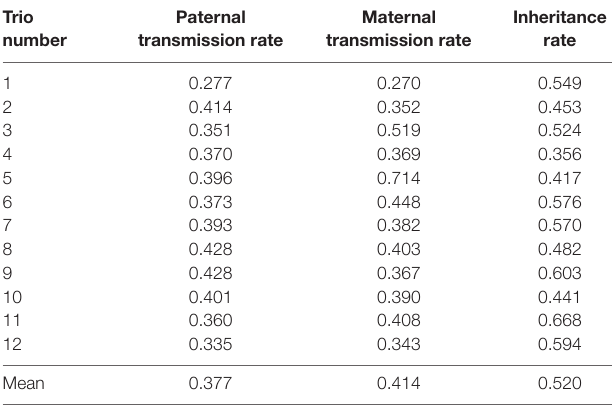
TABLE 2 | Transmission and inheritance rates in parent–offspring trios.